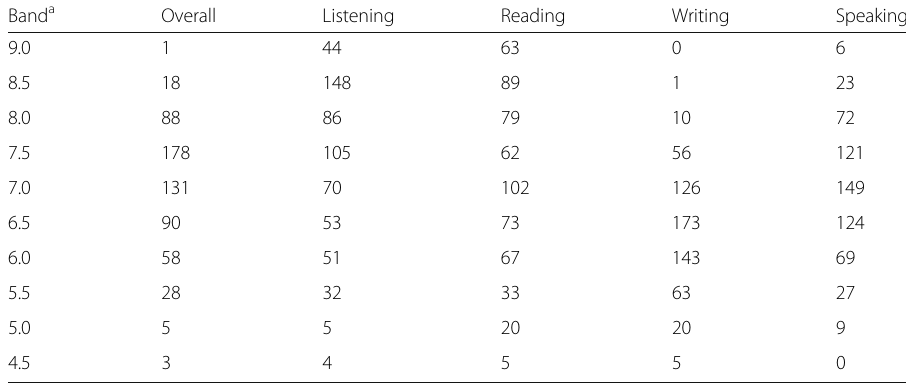
Table 3 Profile of candidates ’ IELTS scores overall and by sub-test Band a